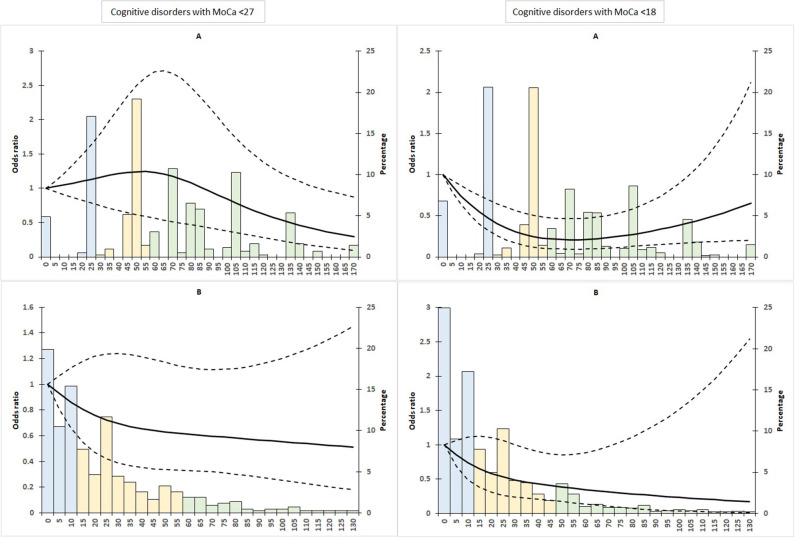
Adjusted (age, gender, years of education) spline analyses of cognitive decline risk (MoCA) by domestic activities (A) and leisure activities (B). Dashed lines represent 95% confidence intervals. The score distribution is represented by the histogram in the background with the blue bars for the reference class, the yellow bars for the moderate activity class and the green bars for the high activity class.